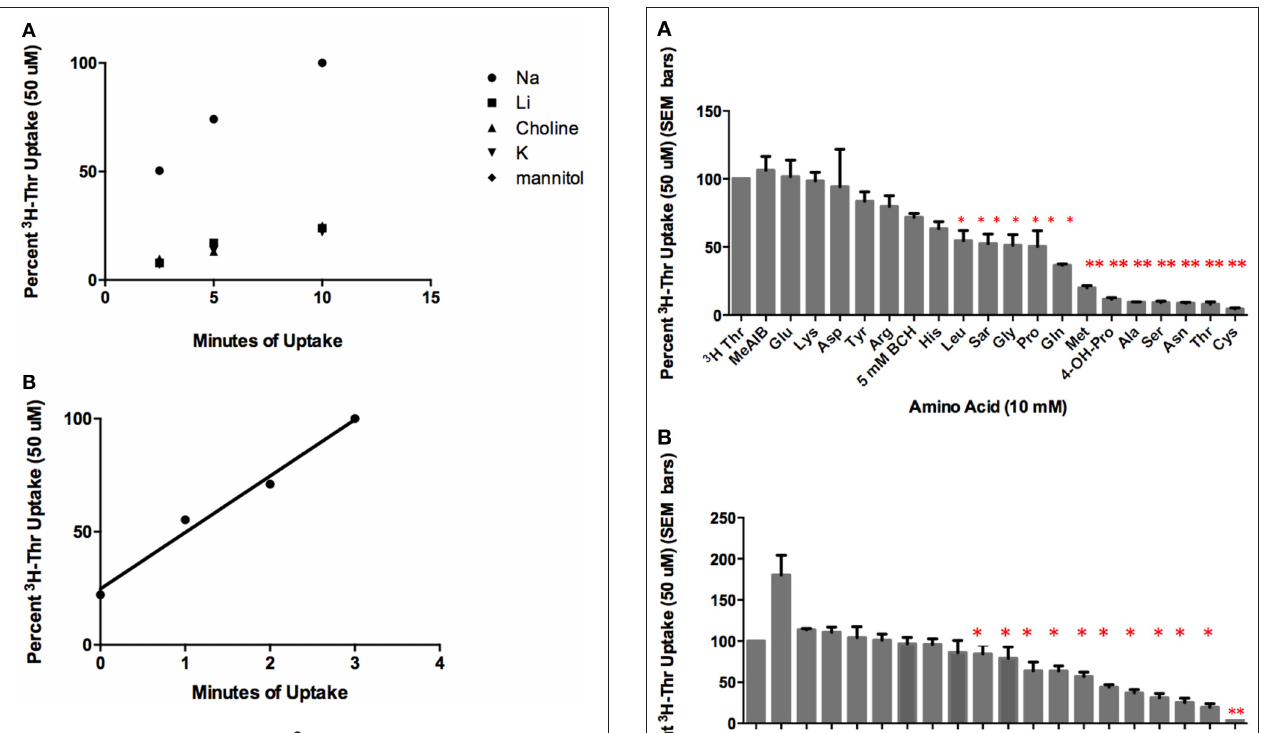
FIGURE 1 | Time course of 50 uM [ 3 H]-Thr uptake in the presence of 140mM NaCl, LiCl, Choline Cl, or KCl, or 280mM Mannitol. (A) Uptake was measured at 2.5, 5, and 10min and increased significantly with time ( p < 0.0001 ) ( n = 3 ; 1 replicate experiment for each time point). (B) Time course of 50 uM [ 3 H]-Thr uptake in the presence of 140mM NaCl at 0, 1, 2, and 3min. Uptake increased significantly with time ( r = 0.99 , p = 0.01 , 1 replicate experiment for each time point).